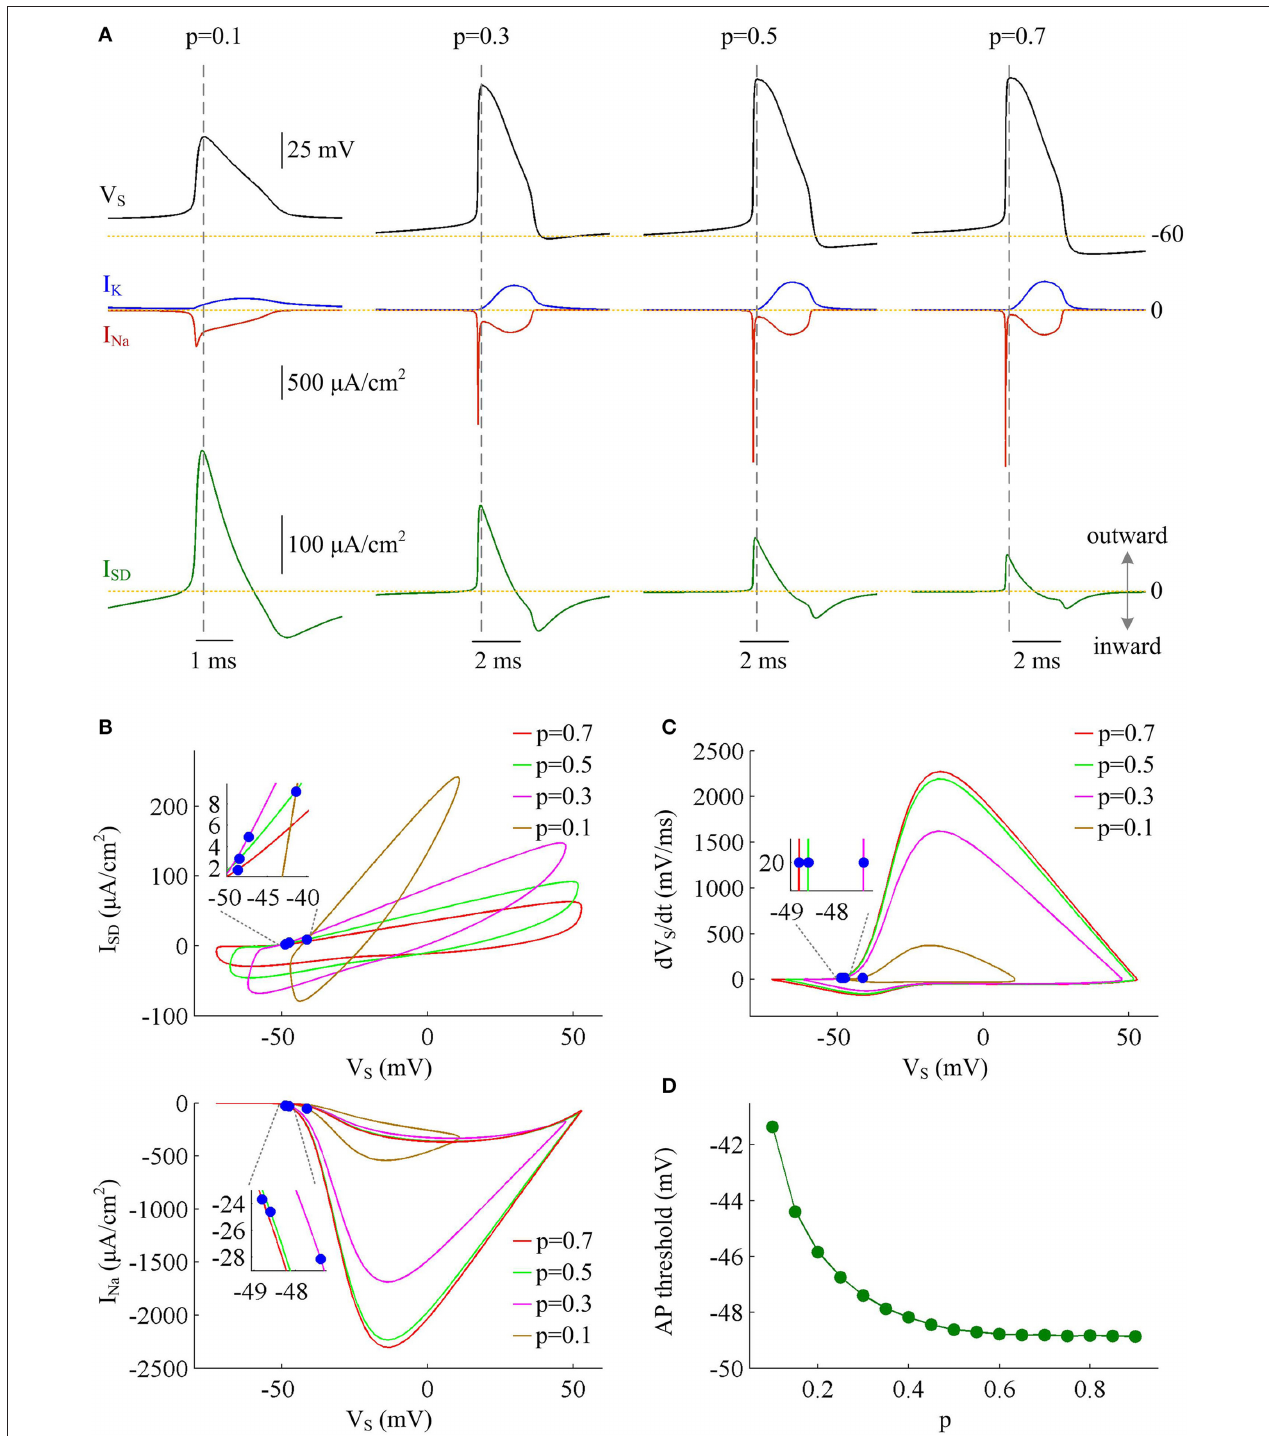
FIGURE 2 | Inefficient Na + entry arises from increased overlap between I SD and I Na as dendrite area increases. (A) I Na (red), I K (blue), and I SD (green) underlying the APs with different values of parameter p , which have been indicated on the top of the panels. (B) Top panel depicts the relationship between internal current I SD and somatic voltage V S (i.e., I SD - V S curve) for each AP shown in (A) . Bottom panel shows relevant I Na - V S curves. (C) Phase plot of d V S /d t vs. V S for the APs. Blue dots in (B,C) indicate where the APs are initiated. (D) AP threshold decreases as a function of p . The threshold voltage is defined as the V S at which d V S /d t crosses 20 mV/ms during the upstroke of the spike. I D = 3 µ A / cm 2 , g c = 0.5 mS / cm 2 .